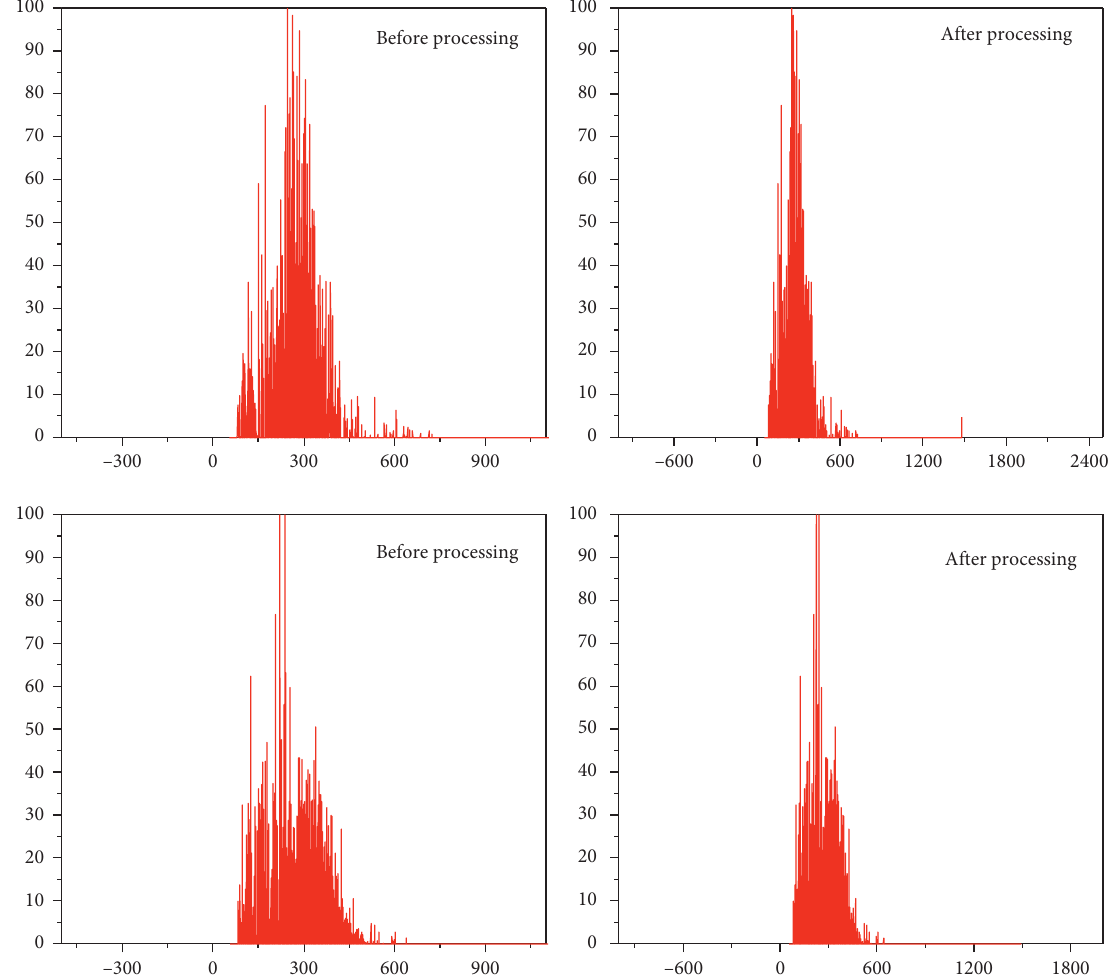
Figure 13: Comparison diagram of the effect of flight uniformity correction + defect pixel replacement.